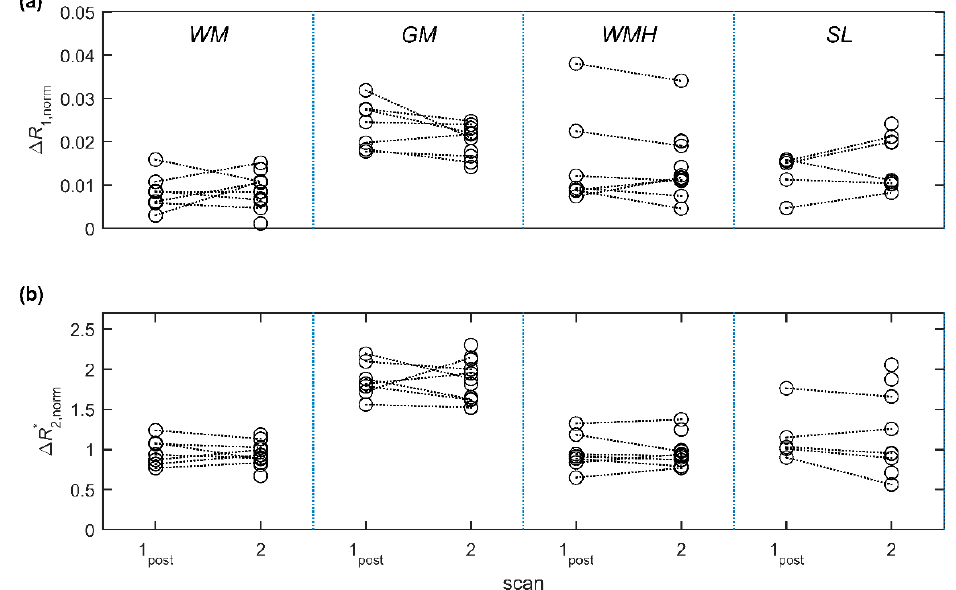
∆ R ∗ at scan 1 post 1,norm and ( b ) 2,norm ) to cerebral blood 2,norm